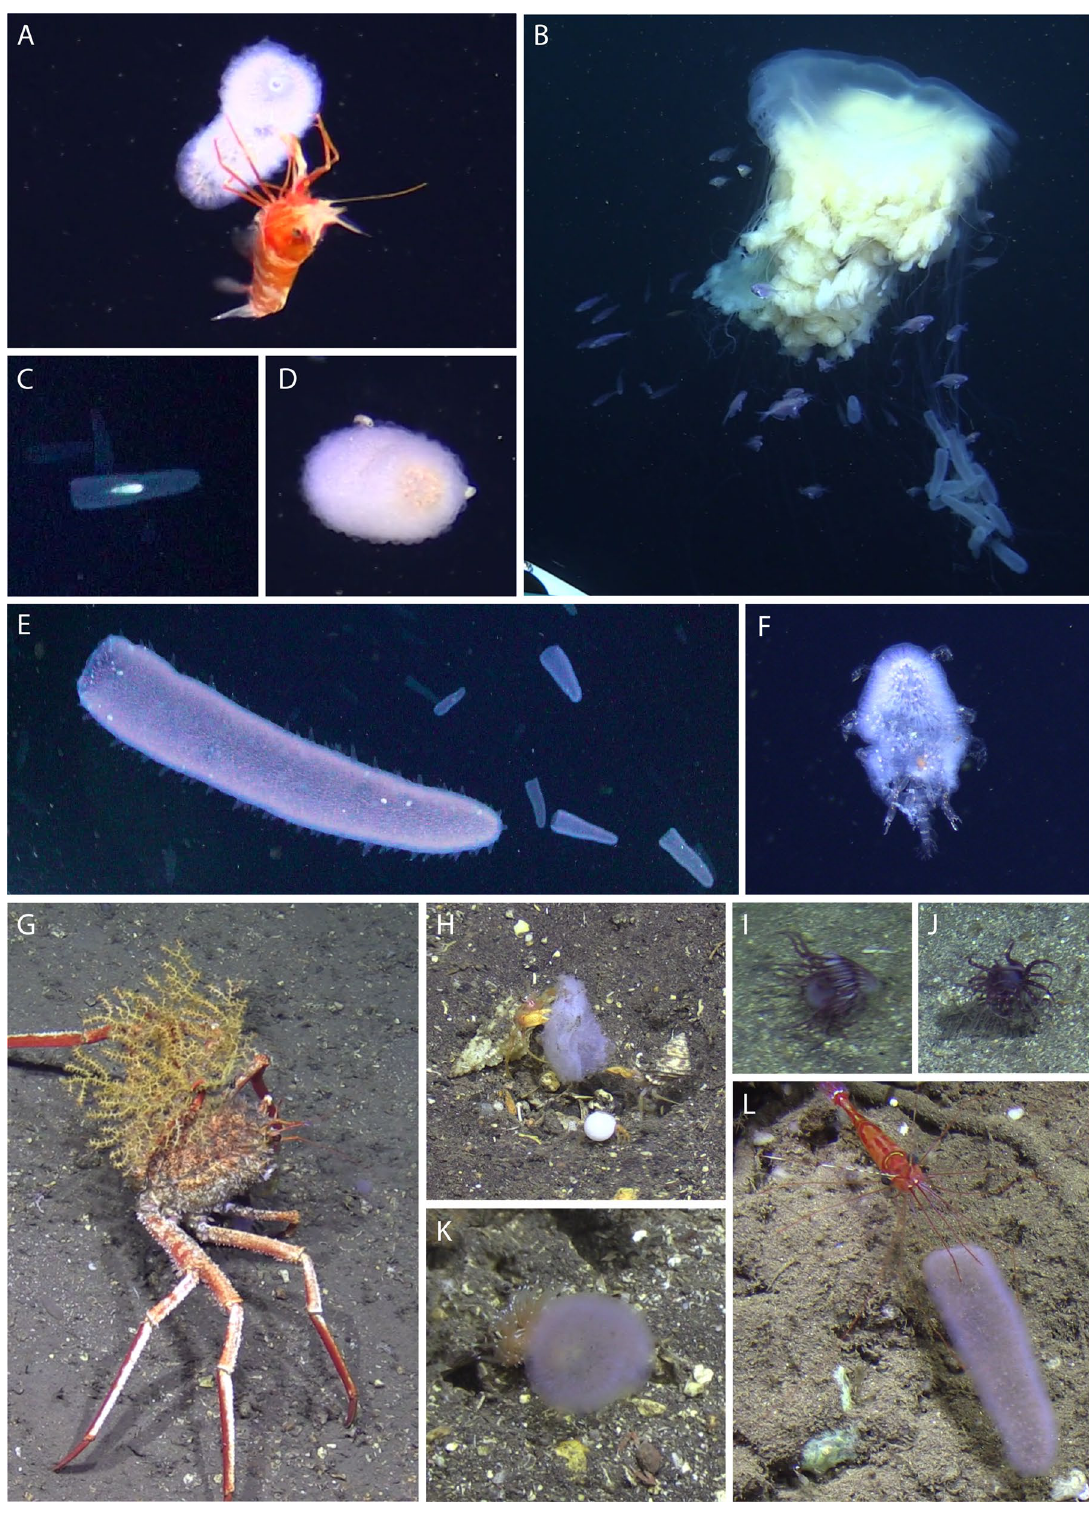
Figure 4. Pelagic ( A – F ) and benthic ( G – L ) animals associated with P. atlanticum in the eastern tropical North Atlantic, observed in February 2018 and 2019. ( A ) Unidentified Oplophoridae and ( B ) Drymonema gorgo feeding on pyrosomes. ( C ) An unidentified fish swimming inside pyrosome. ( D , E ) Unidentified hyperiid amphipods and ( F ) Phronima sp. using P. atlanticum as substrate, potentially feeding and reproducing on it. ( G ) An unidentified decorator crab, ( H ) three unidentified Anomura, ( I , J ) two unidentified Actiniaria, ( K ) Dondice sp. and ( L ) Pandalopsis sp. feeding on pyrosomes. All images were recorded with JAGO with exception of ( C ) and ( E ), which were recorded with